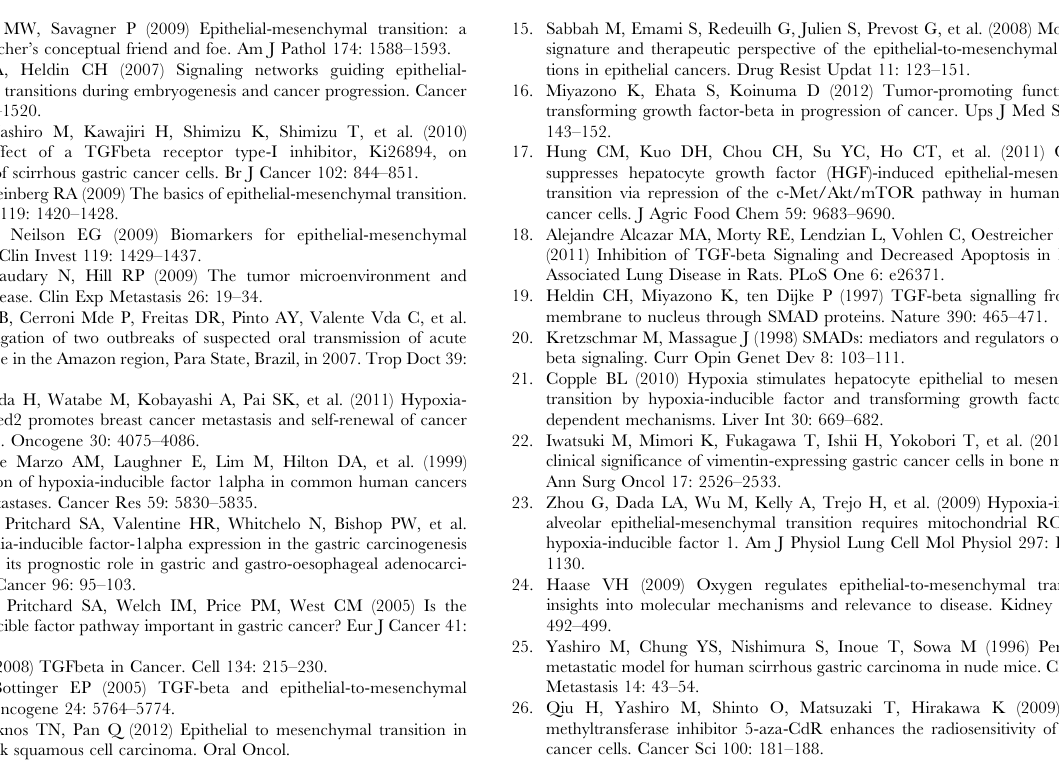
Figure S1 Morphologic changes of gastric cells under a hypoxic condition. In MKN-7, MKN-45, MKN-74, and KATO-III, morphologic changes were not found under